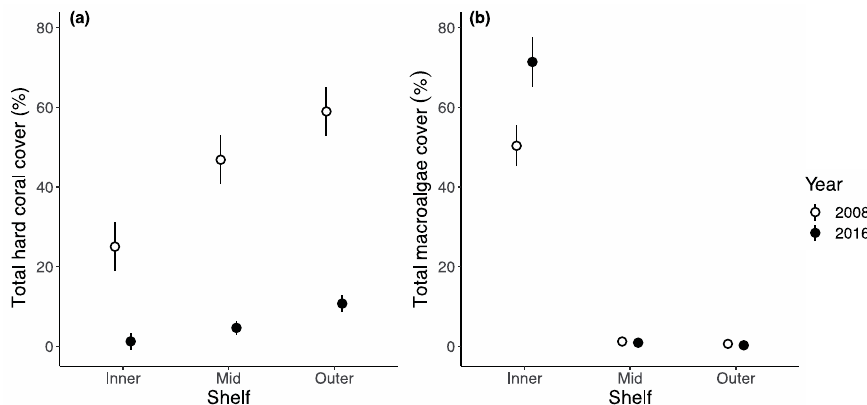
Figure 2. Cross-shelf differences (fitted values 95% confidence intervals) in ( a ) total hard coral cover (%) and ( b ) total macroalgal cover (%) in 2008/9 (white) and 2016 (black).